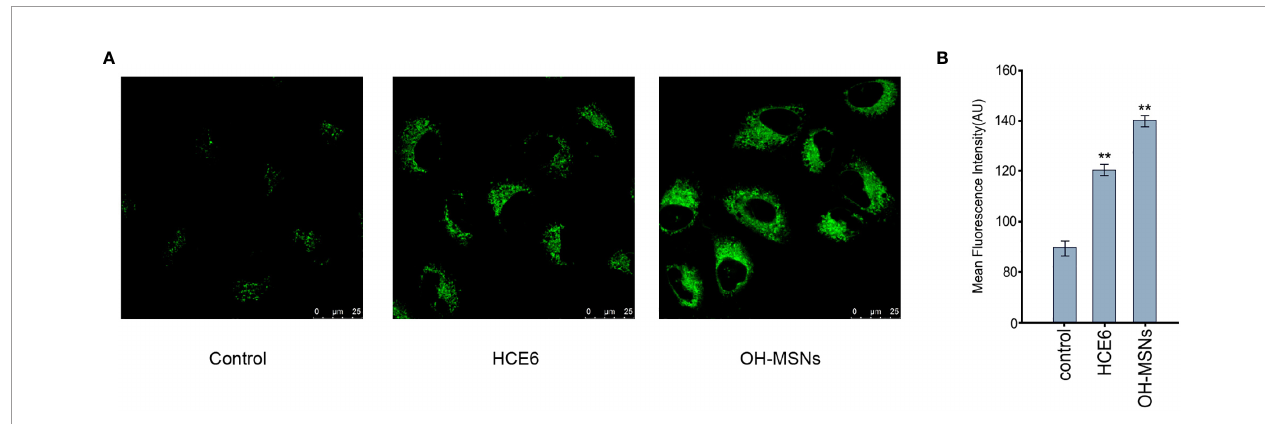
FIGURE 3 | The cellular uptake of OH-MSNs. (A, B) The cellular uptake of OH-MSNs was analyzed by confocal fl uorescence microscope in FRH0201 cells. **P < 0.01